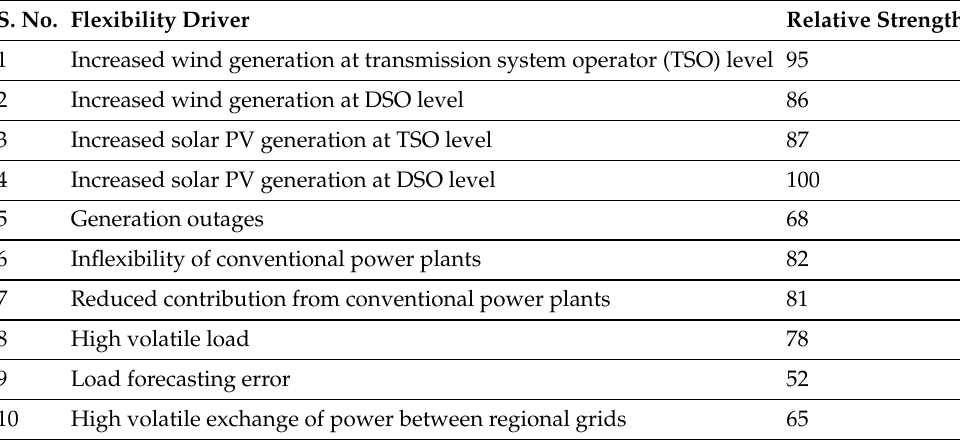
Table 3. Drivers and relative increased need for